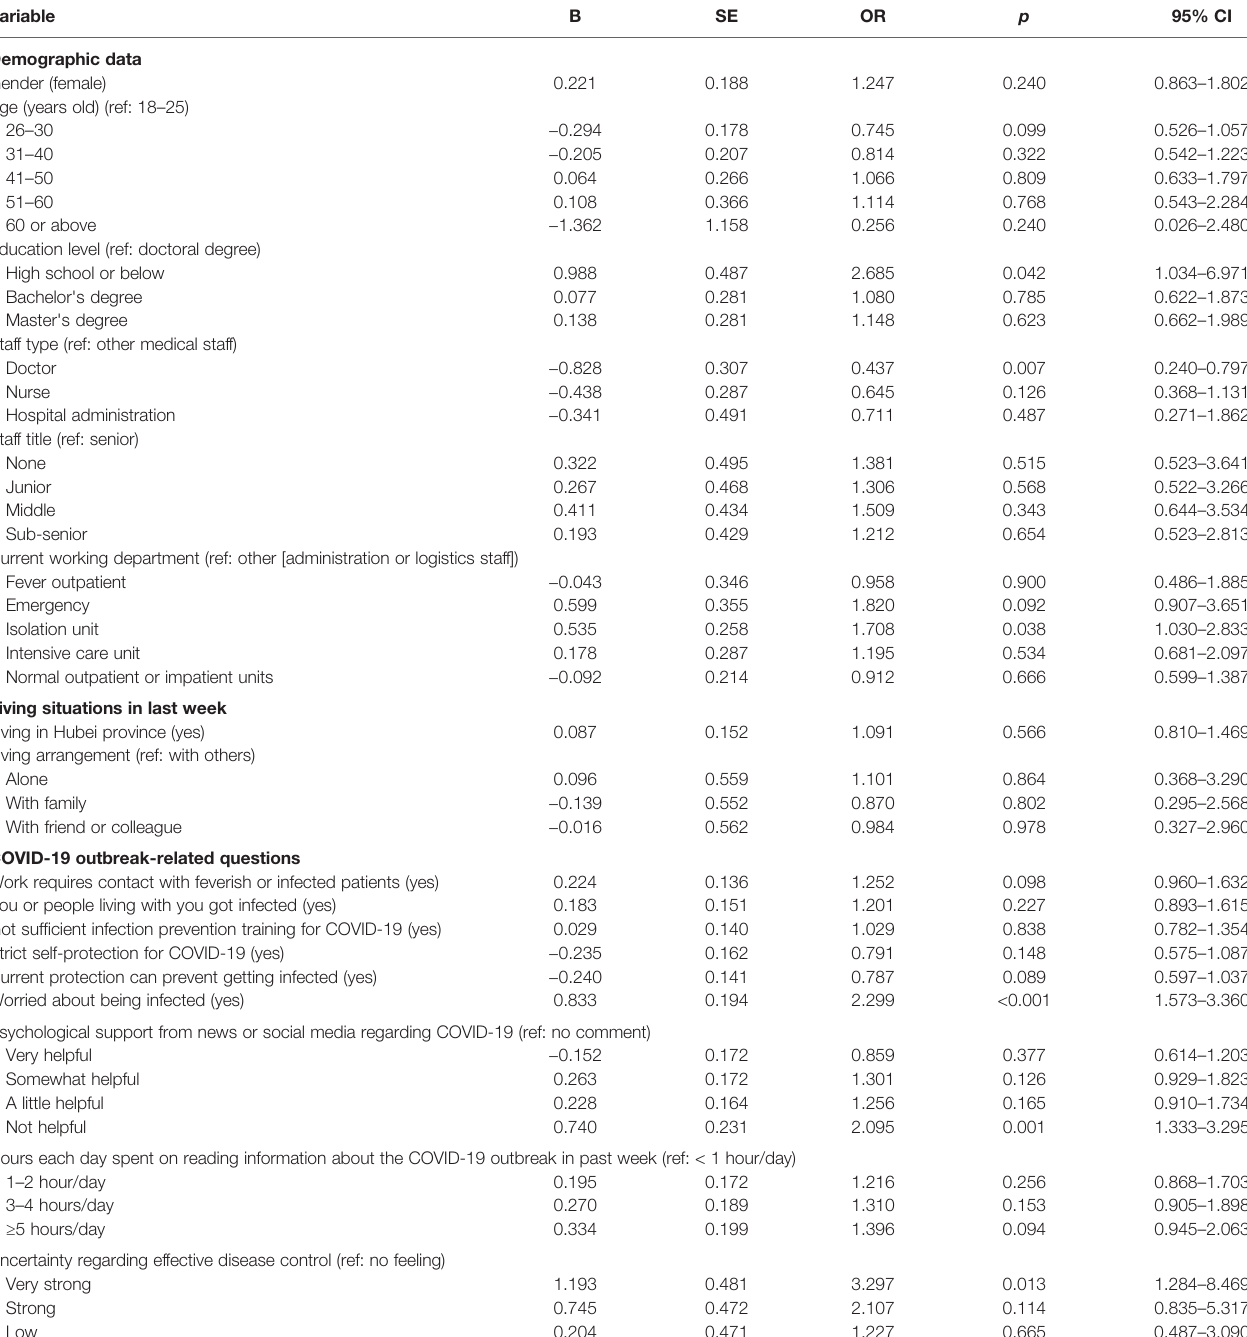
TABLE 2 | Multiple binary logistic regression analysis of insomnia-related